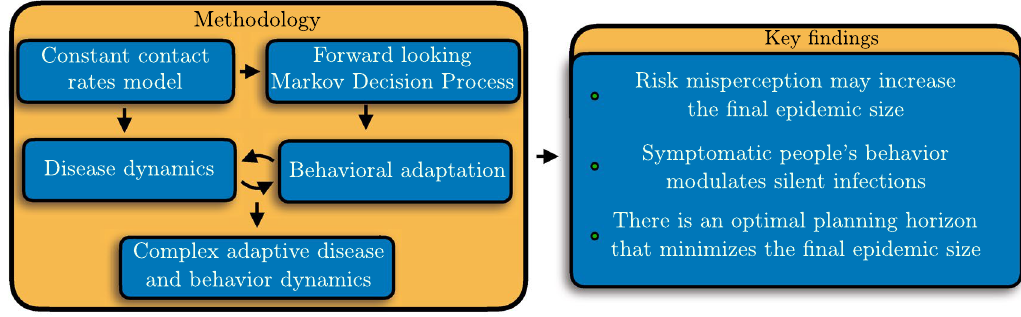
Figure 6. Methodology components of our adaptive behavior model and key